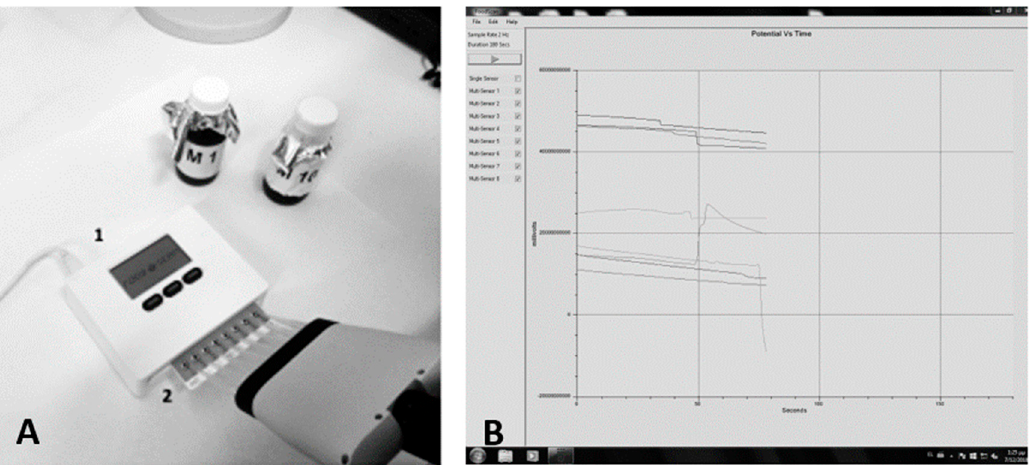
Figure Figure 1. ( A ) The cell-based, BERA-compatible portable potentiometric biosensor (1) with a custom- designed sensor strip-connection interface (2) allowed for measurements of up to eight channels